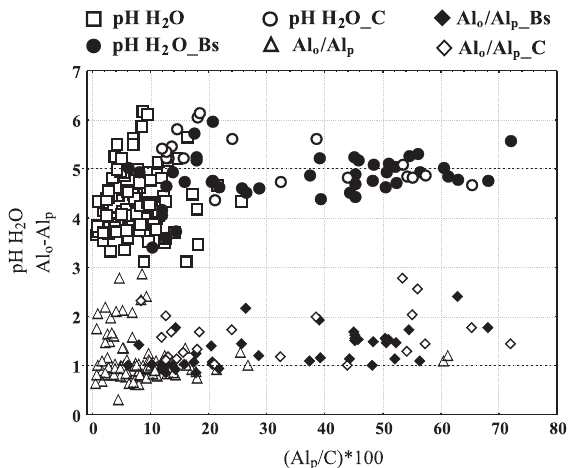
Figura 5. Relação entre a percentagem de saturação por Al no húmus (Al /C)*100 e as seguintes p variáveis: pH extraído em água (pH H O) e a 2 relação Al /Al ; pH H O e Al /Al referem-se a o p 2 o p todo o conjunto de horizontes e perfis estudados, excetuando-se horizontes Bs, Bhs, Bsm e C; pH H O_Bs e Al /Al _Bs, aos horizontes espódicos 2 o p bem drenados dotados de subscrito “s” (Bs, Bhs e Bsm); pH H O_C e Al /Al _C, aos horizontes C. 2 o p As linhas tracejadas indicam os valores de 1 e 5 para Al /Al e pH, o p